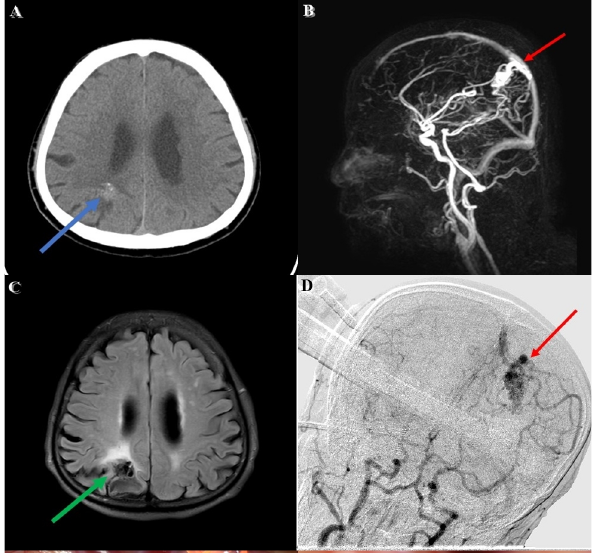
Figure 1. Preoperative and intraoperative images . ( A ) Right parietal suspected vascular lesion with hemorrhagic vestige from computed tomography (CT) (blue arrow). ( B ) Preoperative reconstructive magnetic resonance angiography (MRA) revealed the tangled vascular lesion (red arrow) ( C ) Flow voiding phenomenon was noted from T2-weighted image (green arrow). ( D ) Intraoperative digital subtraction angiography (DSA) for confirmation of lesion location.